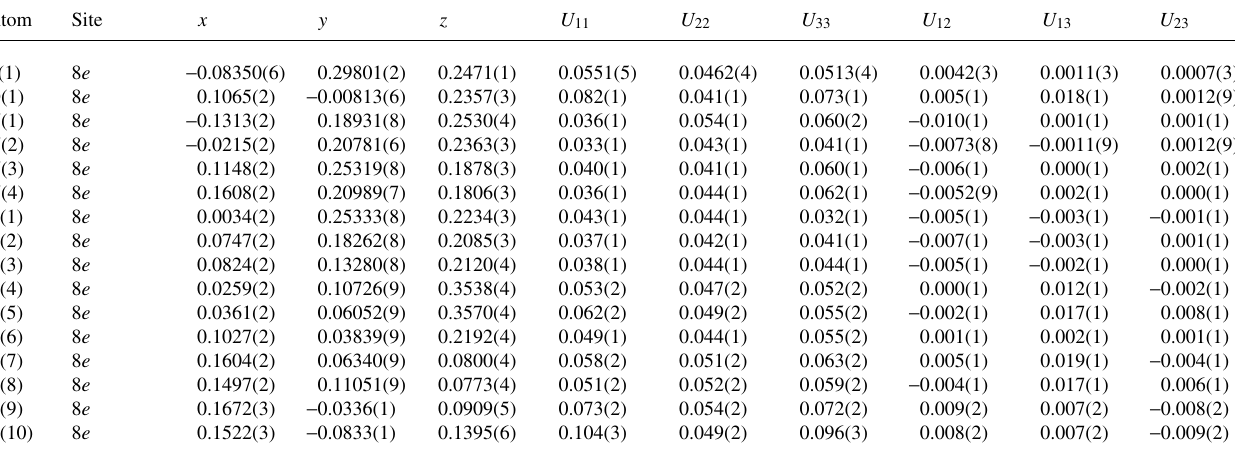
Table 3. Atomic coordinates and displacement parameters (in Å 2 )